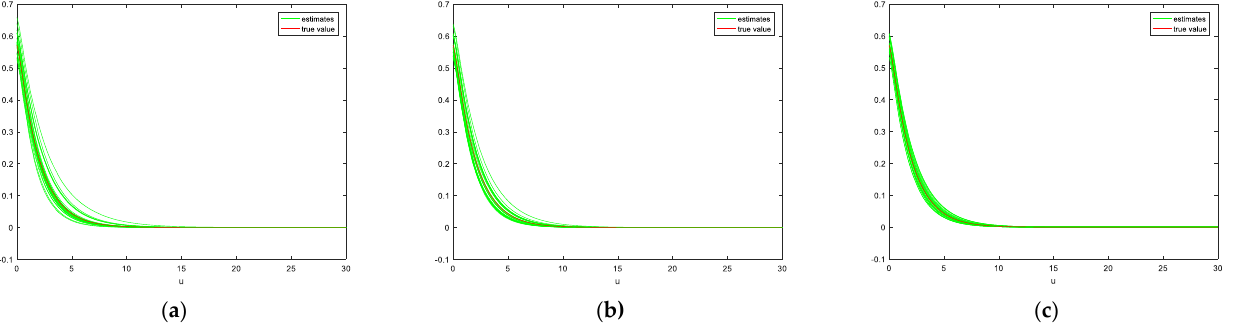
Figure 2. Estimation of the ruin probability for Erlang (2) claim size density: ( a ) T = 120 , ( b ) T = 180 , ( c ) T = 360.